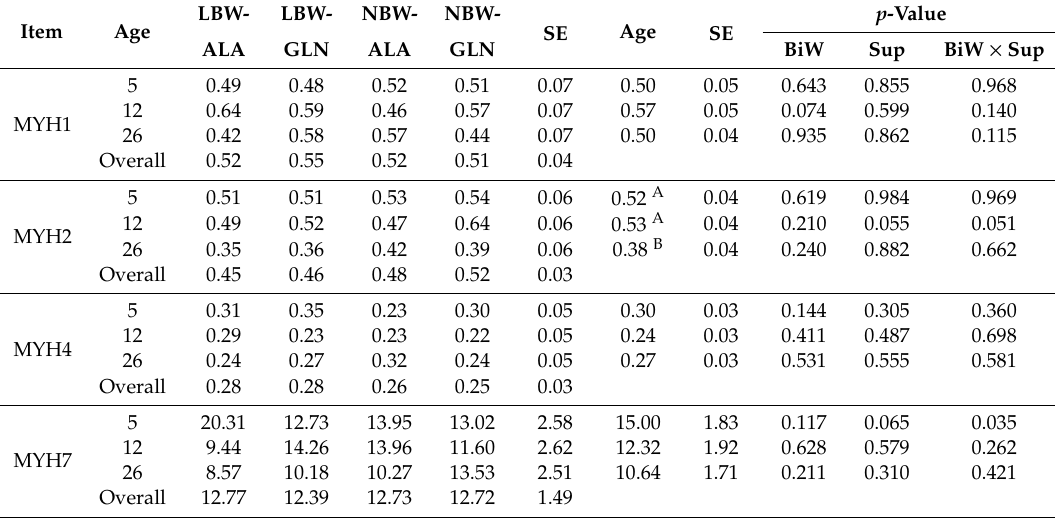
Table 4. Relative normalized protein abundance of MYH isoforms in M. longissimus of low (LBW) and normal birth weight (NBW) piglets supplemented with glutamine (GLN) or alanine (ALA) between 1 and 12 dpn ( n = 12 per group and